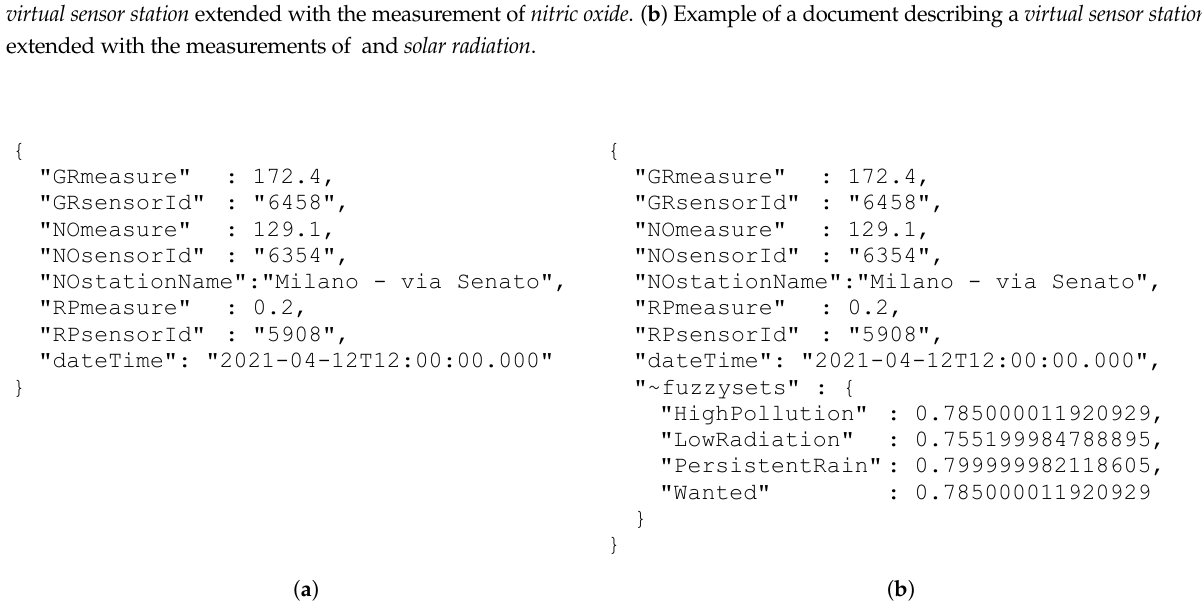
Figure 12. Examples of documents in the temporary collections generated by line 28 ( a ) and line 32 ( b ). ( a ) Example of a document describing a measure triplet . ( b ) Example of a document describing a measure triplet after an evaluation of the fuzzy